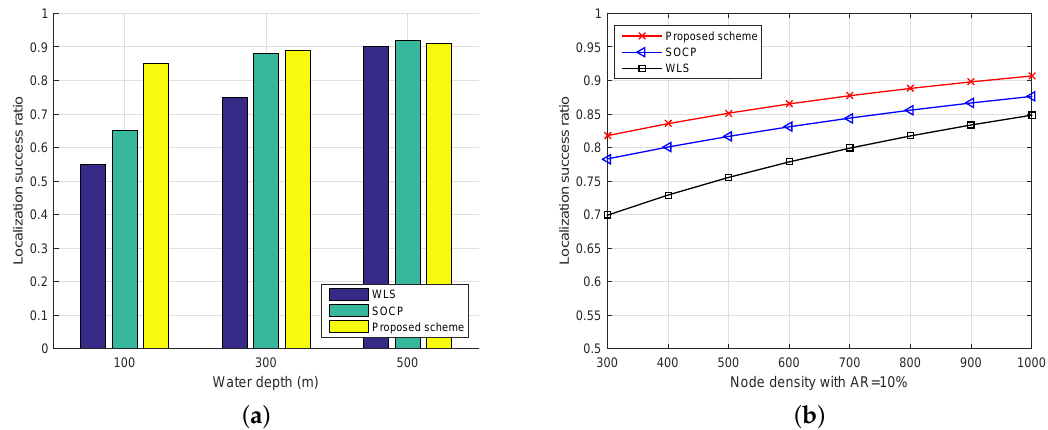
Figure 7. Comparison between the localization schemes. ( a ) Impact of water depth; ( b ) Influence of node